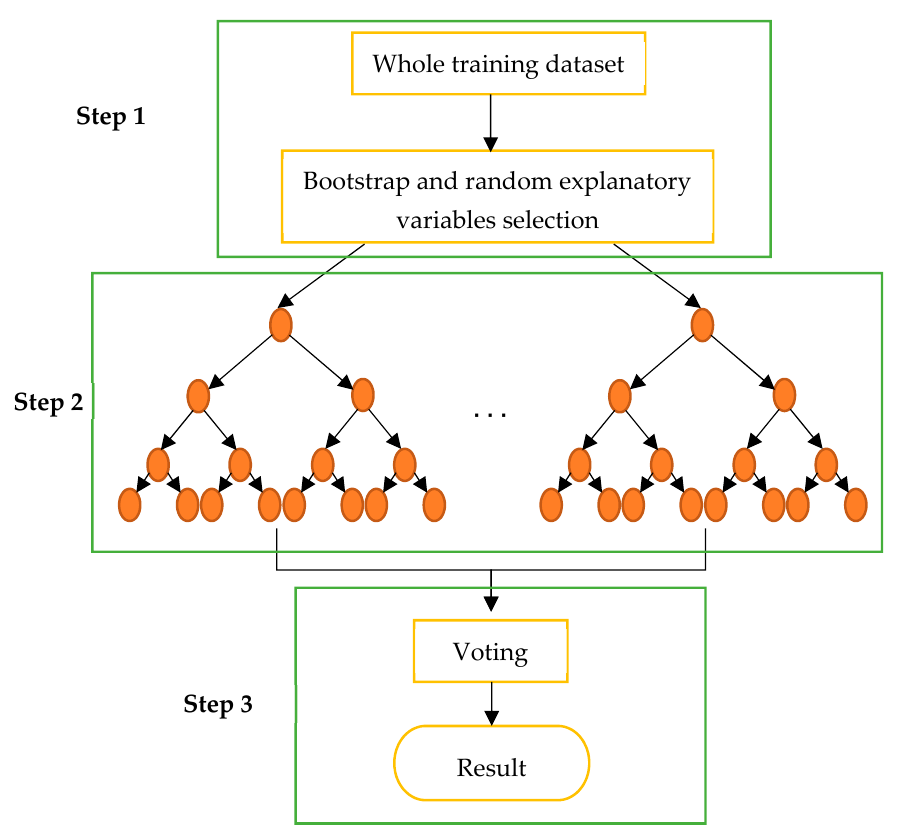
Figure 5. The random forest (RF) working process.